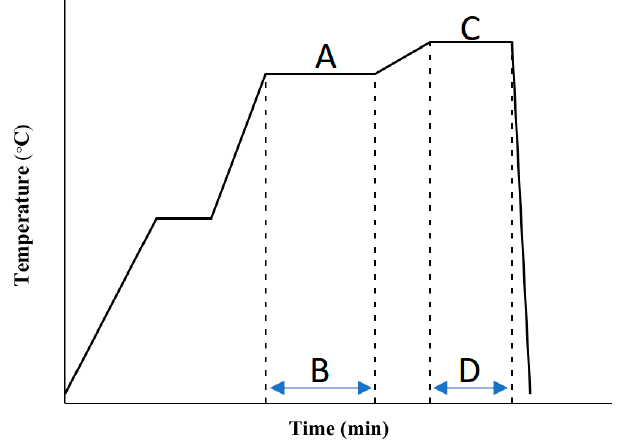
Figure 3. Vacuum brazing process: A: soaking temperature; B: soaking time; C: brazing temperature; D: brazing time. Table 3. Control factors and their levels in vacuum brazing.